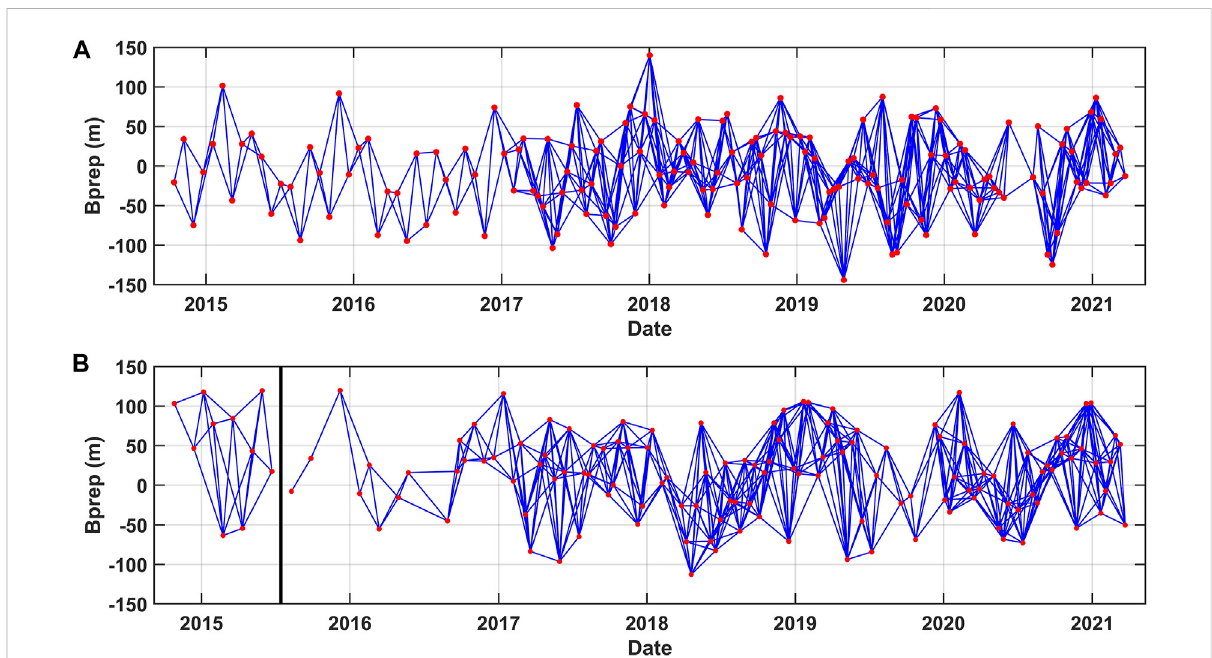
FIGURE 4 BaselinenetworkforSentinel-1SARimages,indicatedasreddots,from (A) ascendingtrackand (B) descendingtrack.Bluelinesrepresentallthe interferograms used in the time-series analysis after removing the ones with low coherence and/or unacceptable unwrapping errors. Bprep is a perpendicular baseline and black thick line in (B) indicates a